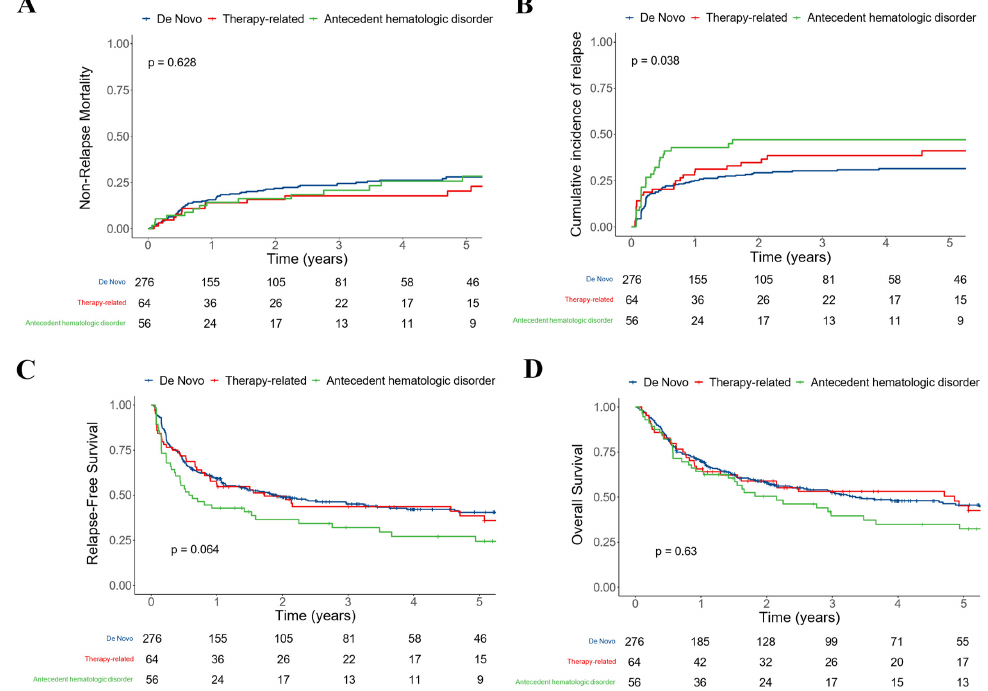
Figure 3. Post-HCT outcomes for 396 adults with AML undergoing allogeneic HCT following non- MAC while in first or second morphologic remission, stratified by disease status at diagnosis (de novo vs. therapy-related vs. antecedent hematologic disorder): ( A ) Non-relapse mortality; ( B ) relapse; ( C ) relapse-free survival; and ( D ) overall survival.